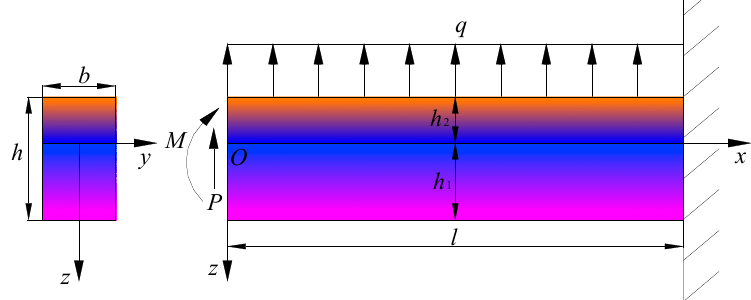
Figure 1. Scheme of a bimodular functionally graded piezoelectric materials (FGPM) cantilever beam under combined loads.